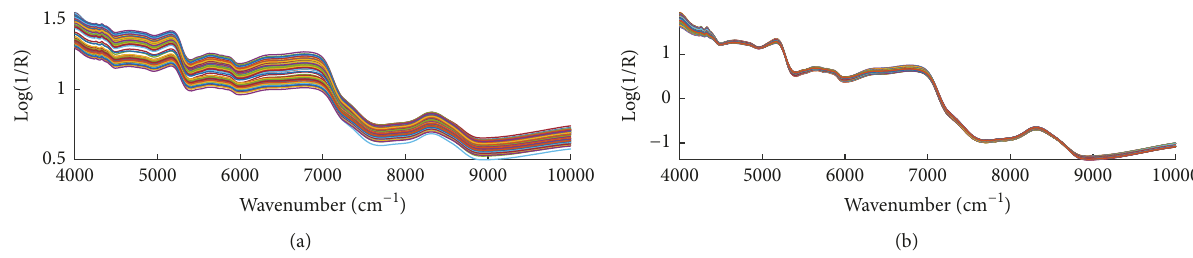
Figure 1: Original near-infrared (NIR) spectra (a) and all the preprocessed spectra (b) by standard normal transformation (SNV).